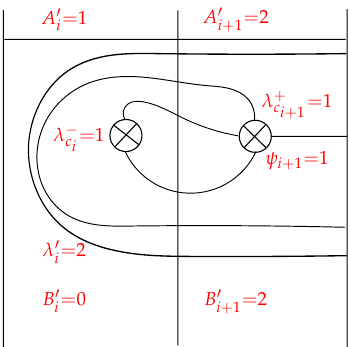
= 1, B (cid:48) i , i + 1